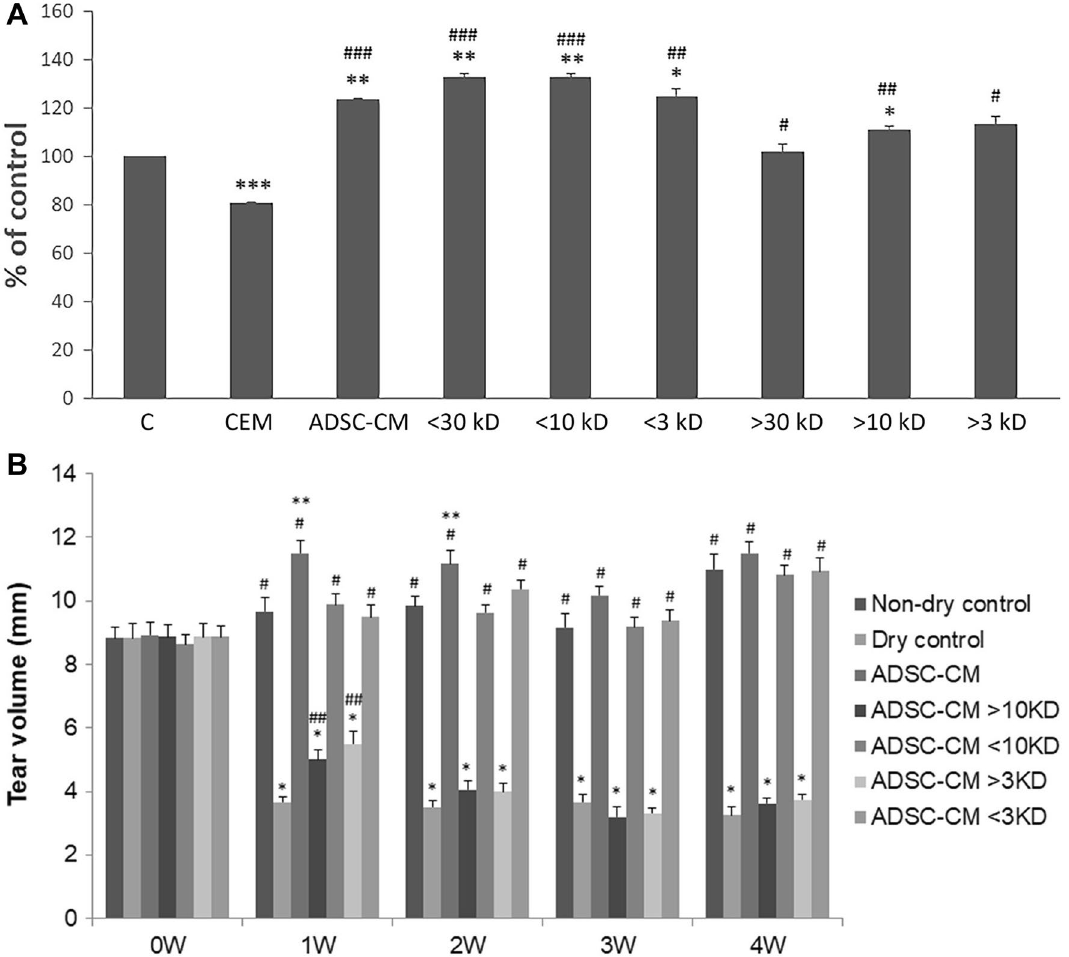
Figure 3. Different size fractions of ADSC-CM showed different protective effects in the HCEC desiccation stress experiment and tear stimulation effects in the controlled-environment chamber (CEC) mice. (A) HCECs treated with fractions of molecular size < 30 kD, < 10 kD, < 3kD after desiccation showed better viability than thosed treated with > 30 kD, > 10 kD, and > 3 kD. (N = 3) *p < 0.05, **p < 0.01, ***p < 0.001 compared with the non-dry control. #p < 0.05, ##p < 0.01, ### p < 0.001 compared with the corneal epithelial cell basal medium (CEM). (N = 5) (B) In the CEC-induced dry eye study, mice reated with fractions ADSC-CM with molecular size < 10 kD or < 3kD had more tear secretion than thosed treated with > 10 kD or > 3 kD. (N = 4). * p < 0.05, ** p < 0.01, *** p < 0.001, compared with Non-dry control. # p < 0.05, # # p < 0.01, # # # p < 0.001, compared with Dry control. The values were expressed as the means ± SD. (N =